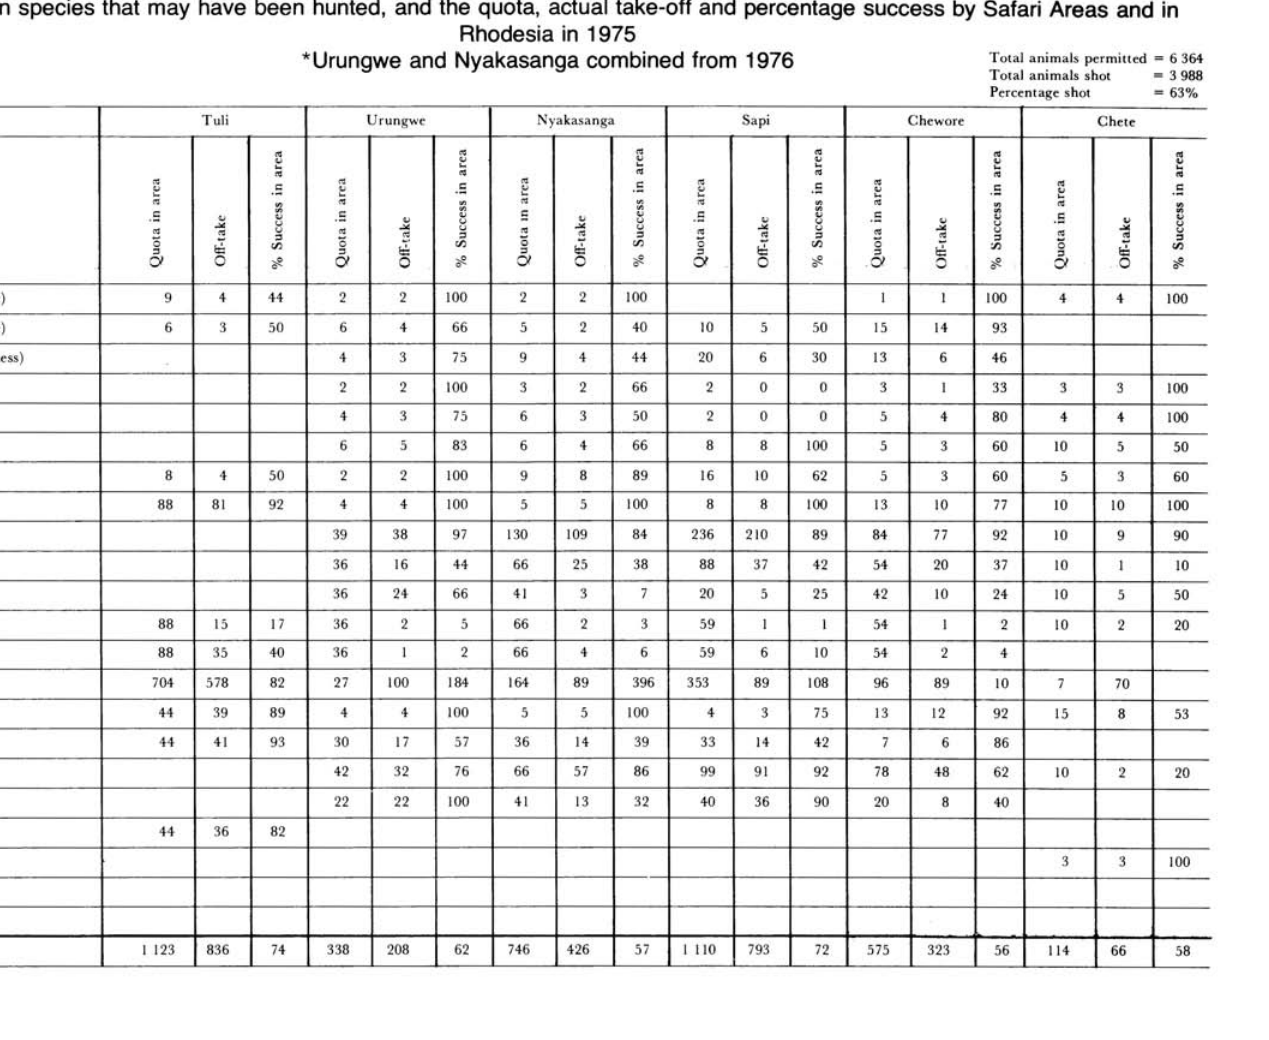
\Vaterhuck Wildebeeste 44 82 Klipspring. Reedbuck Giraffe